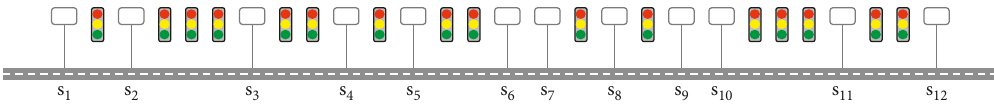
Figure 5: Layout of stops and intersections in the target overlapping segment. Table 1: Timetable for vehicles entering the overlapping segment between 8:00 and 9: 00 AM. � 3 Arrive time for i ( H 1 1